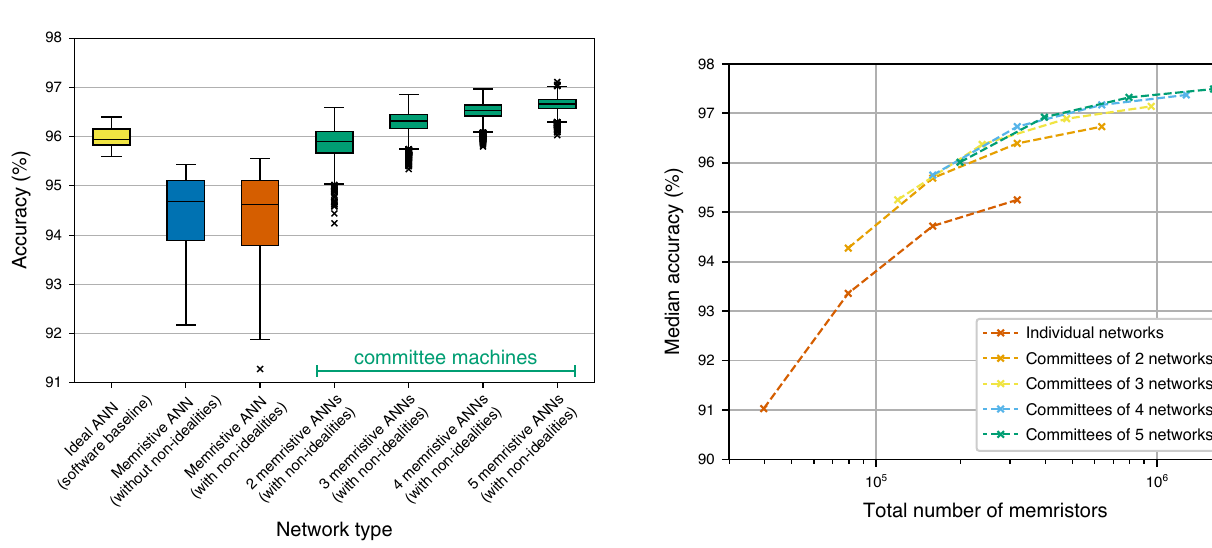
Fig. 8 Accuracy of committee machines when using aVMCO devices. Accuracy achieved by individual networks and their committees when RTN data of an aVMCO device are taken into account. Additionally, interconnect resistance of 0.35 Ω and 0.32 Ω in the word and bit lines, respectively, (from Ta/HfO 2 array) was used to include line resistance effects. The maximum whisker length is set to 1.5 ×